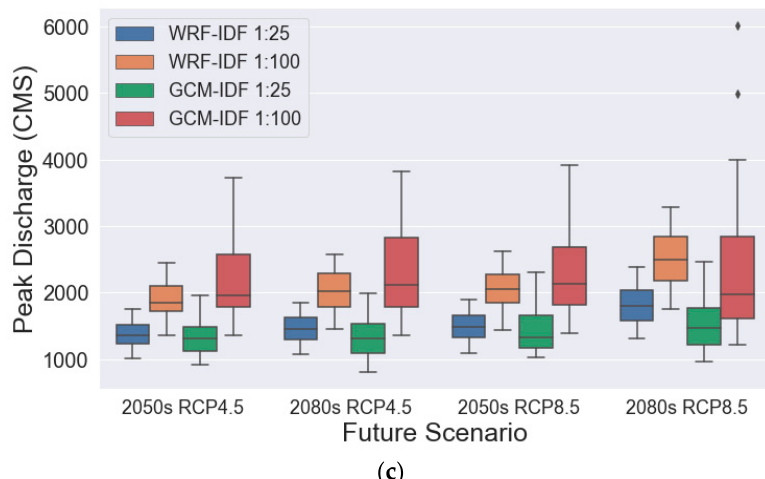
Figure 6. Simulated peak discharge rates corresponding to a 25-year event based on different design storm methods corresponding to ( a ) WRF-IDF and ( b ) GCM-IDF curves. ABM1 (Alternative Block Method) represents constant temperature scaling rate applied to the entire event, and ABM2 shows varied temperature scaling rates applied at each time step. ( c ) Simulated peak discharge rates between WRF- and GCM-IDFs corresponding to 25- and 100-year events.